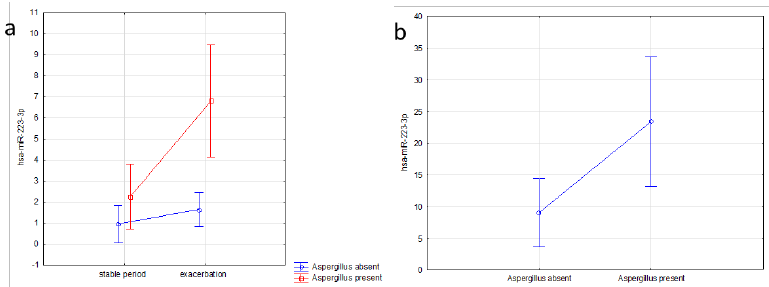
Figure 2. The association of miR-223-3p expression and clinical parameters in CF patients ( a ) in EBC in relation to Aspergillus infection and exacerbation (F = 5.953, p = 0.024, 2-way analysis of variance); ( b ) in sputum supernatant in relation to Aspergillus infection (F = 6.714, p = 0.017, one-way analysis of variance).